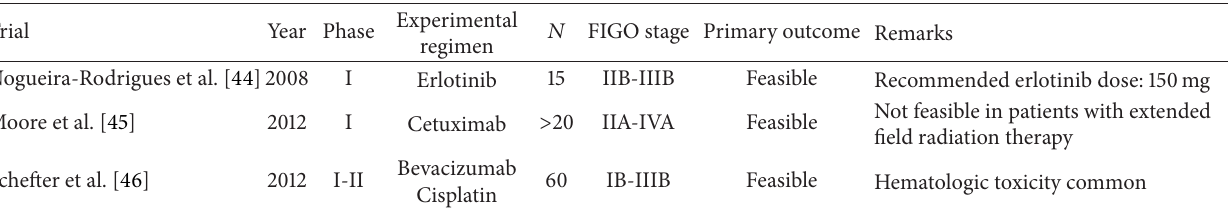
FIGO: International Federation of Gynecologic